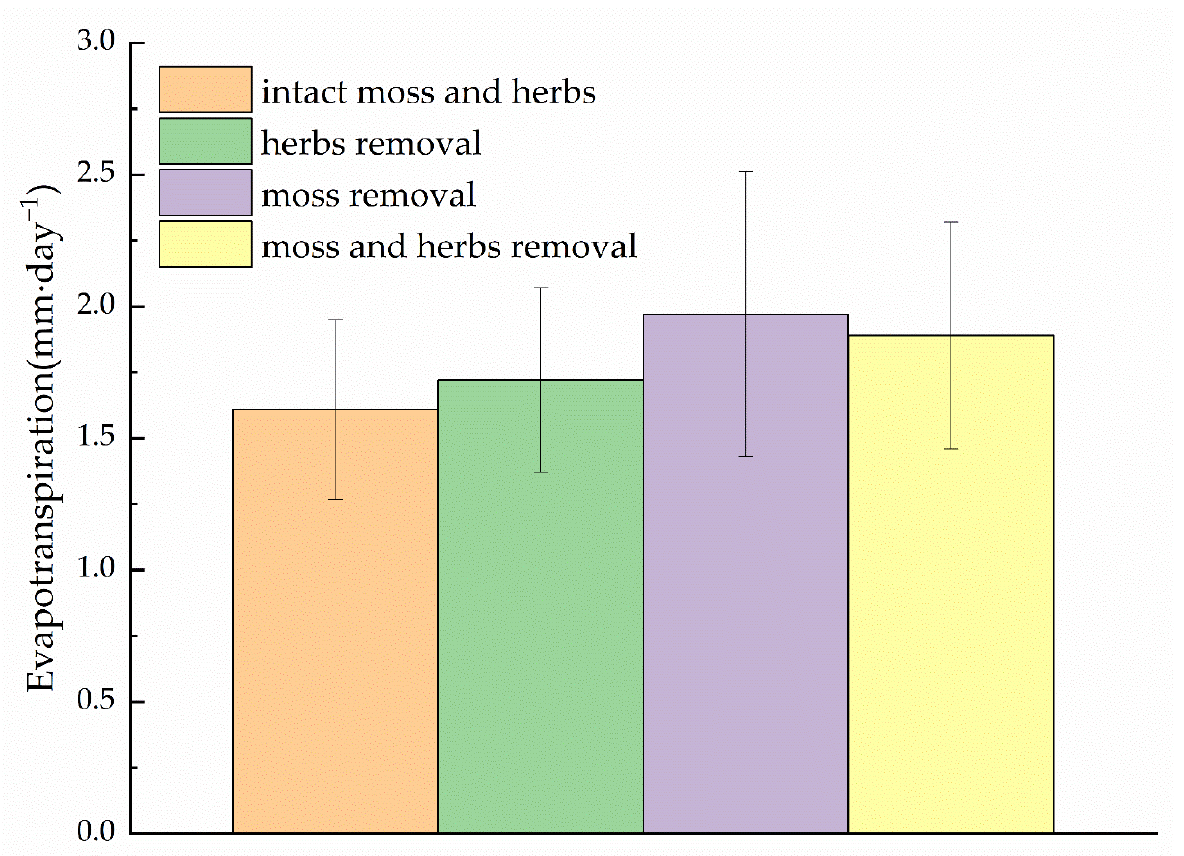
Figure 3. Comparison of daily average evapotranspiration rates between lysimeter treatments between 12 June and 21 September of 2012. Lysimeter treatments consisted of four groups: orange bar, with intact herbs and moss vegetation; green bar, herbs with moss removed; purple bar, moss with graminoid removed; and yellow bar, with moss and graminoid removed. Data are mean values ± SE ( n = 9 lysimeters). Significances of treatment effects of moss removal and graminoid removal on evapotranspiration are provided in Table 2.